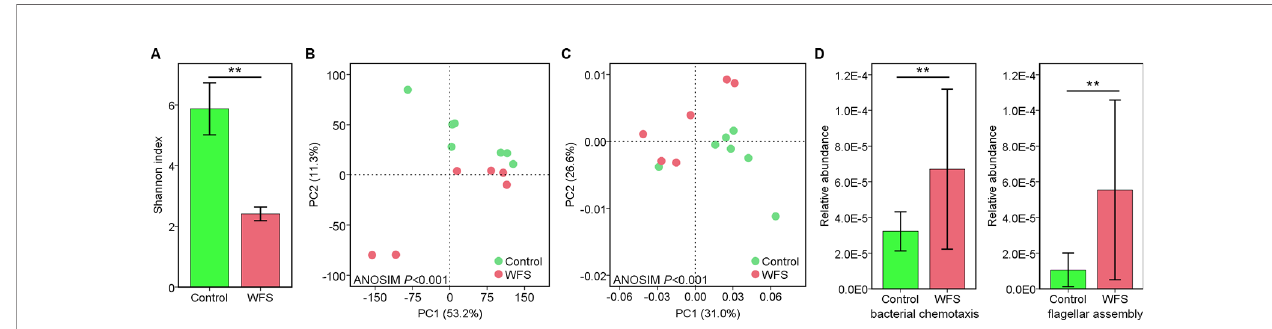
FIGURE 1 | Identi fi cation of the microbial alterations in white feces syndrome (WFS). (A) The a -diversity comparison between Control (n = 7) and WFS (n = 6) groups. Shannon index, P = 0.003 (Student's t -test); (B) Samples were clustered into two group by PCoA using Bray-Curtis distance. The microbial composition differed signi fi cantly between Control and WFS groups. (C) Comparative analysis of microbial gene functions. Principal coordinate analysis (PCoA) based on the relative abundance of all Kyoto Encyclopedia of Genes and Genomes (KEGG) orthology groups. (D) Comparison of the relative abundance of bacterial chemotaxis and fl agellar assembly pathways between Control and WFS groups. Each bar represents the mean ± SD of the samples. Signi fi cant differences are indicated by asterisks (**, P